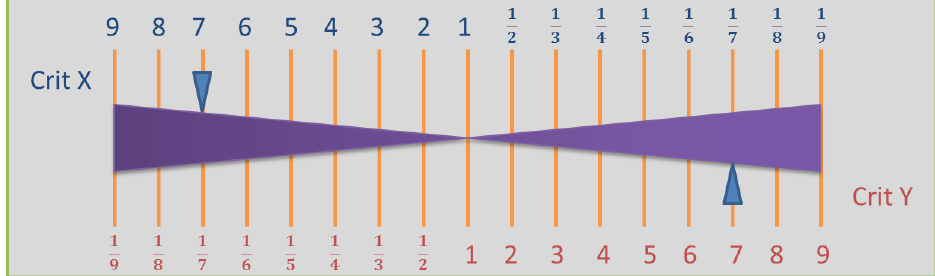
Figure 6. Graphical example scale for category